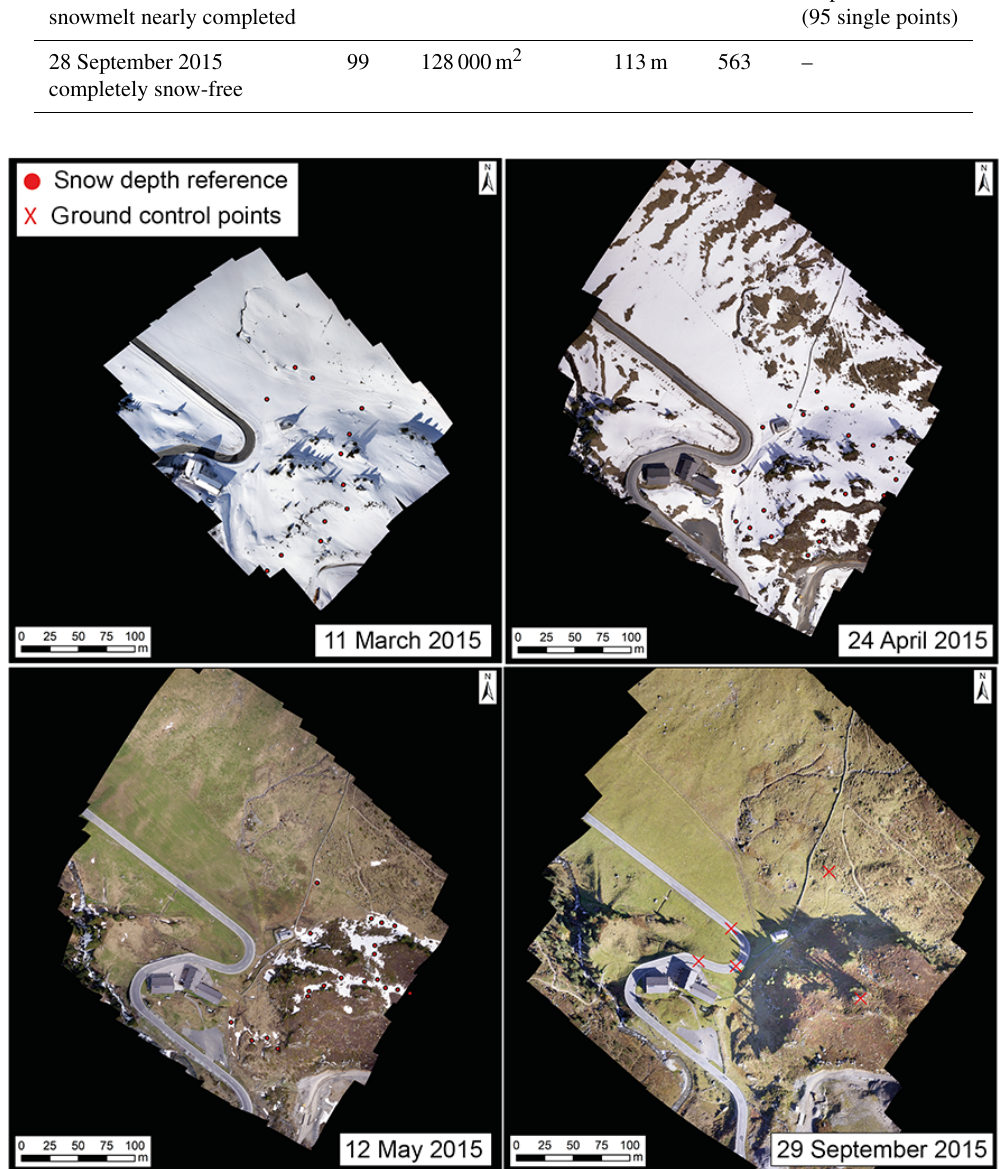
Figure 2. Orthophotos of the four different data acquisitions at Tschuggen depicting the change in snow coverage overlaid by the locations of the manual HS measurements and the applied reference